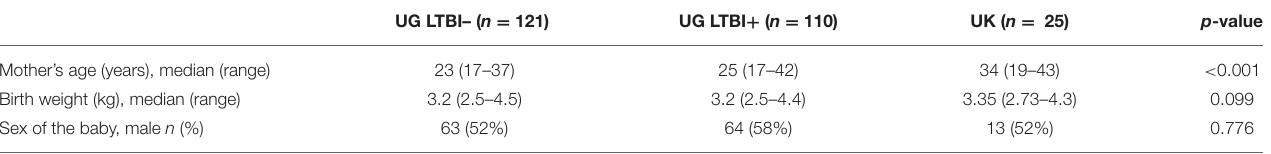
TABLE 1 | Characteristics of study participants.